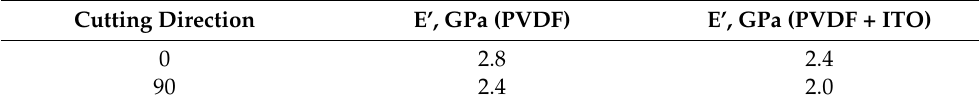
Table 2. Elastic moduli E’ of coated and uncoated PVDF films at a load frequency of 50 Hz. Cutting Direction